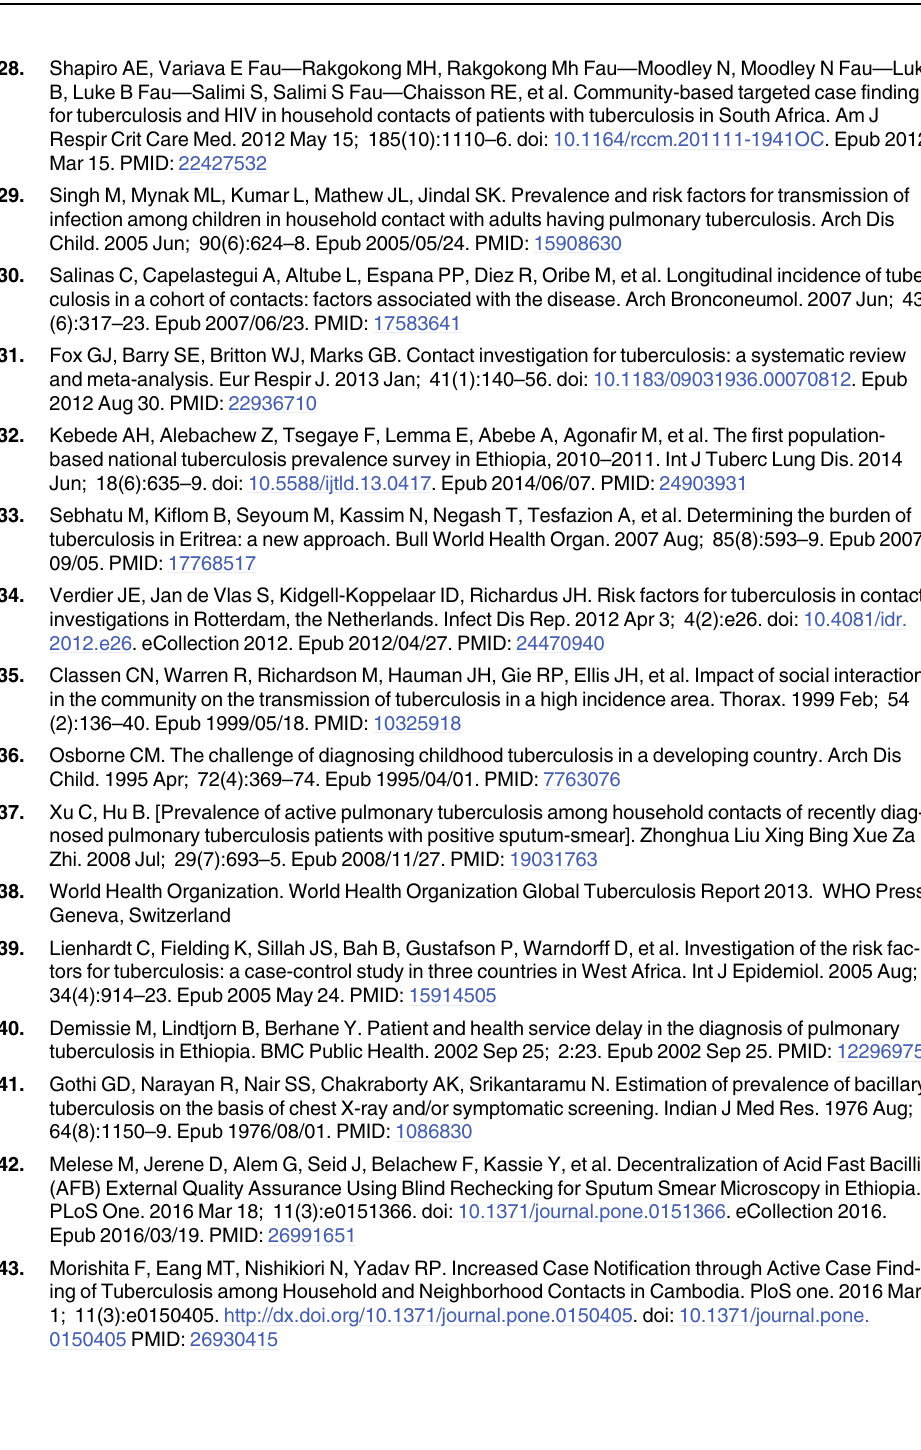
PLOS ONE | DOI:10.1371/journal.pone.0160514 August 2,